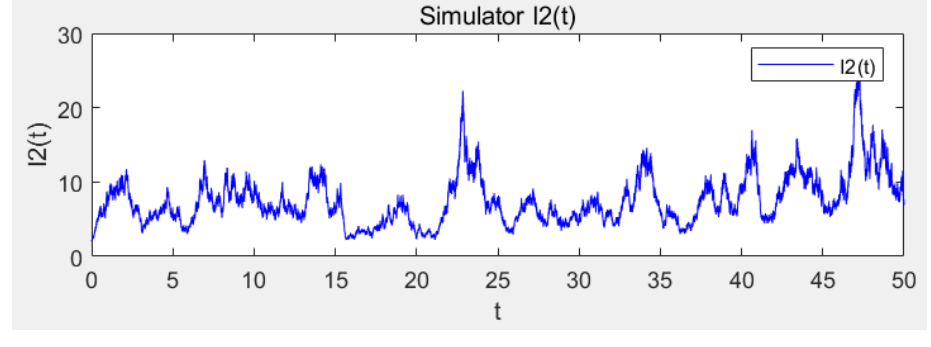
Figure 5. Sample path of I2(t).